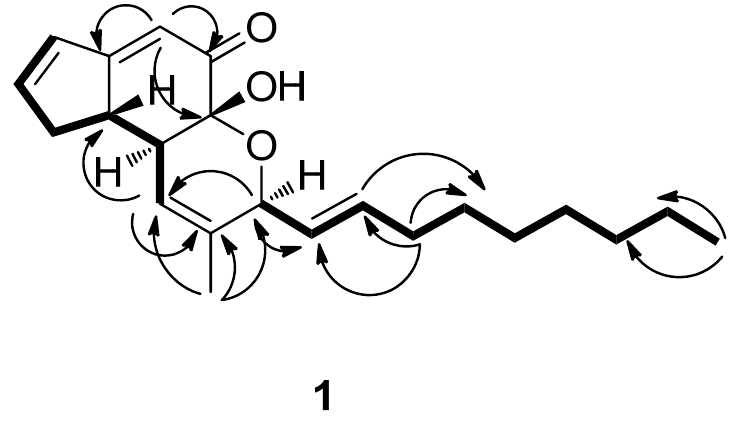
Figure 2. The 1 H- 1 H-COSY, selected key HMBC correlations of 1